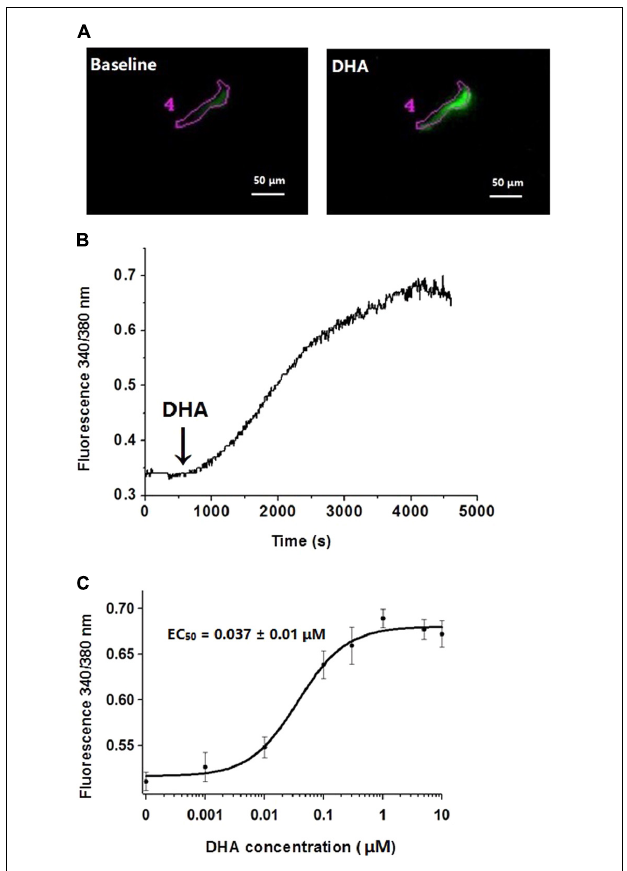
FIGURE 4 | Effects of different concentrations of DHA on cytosolic calcium concentrations. (A) Representative changes of fluorescence intensity of F340 at baseline and after exposure 1 µ M of DHA in rat CASMCs loaded with Fura-2/AM. (B) Representative changes of DHA-induced fluorescence intensity ratios. (C) Concentration–response relationships showing the effects of DHA on fluorescence intensity ratios, n = 5–8